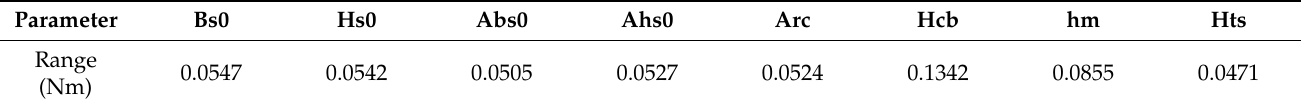
Figure 12. Sensitivity analysis result. Table 3. The variation range of T cpp .